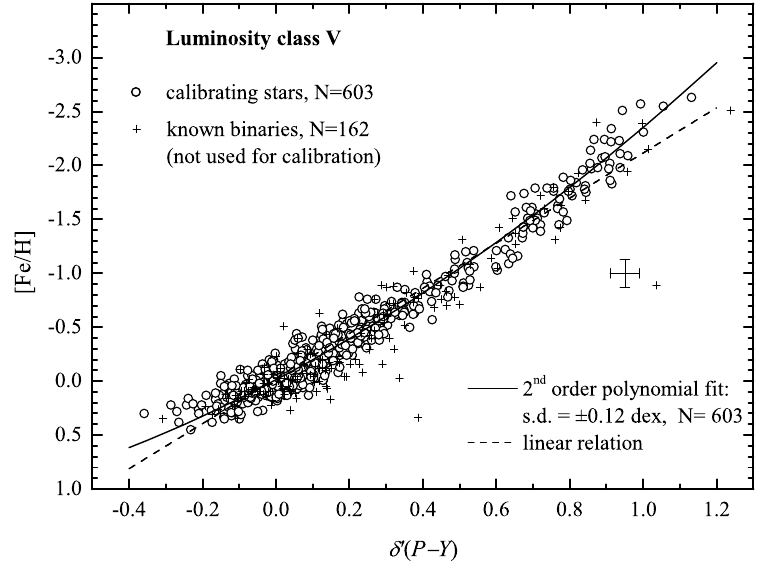
Fig. 5b. (cid:14) ′ ( P – Y ) vs. [Fe/H] relation for calibrating dwarf stars with metallicities from high-dispersion